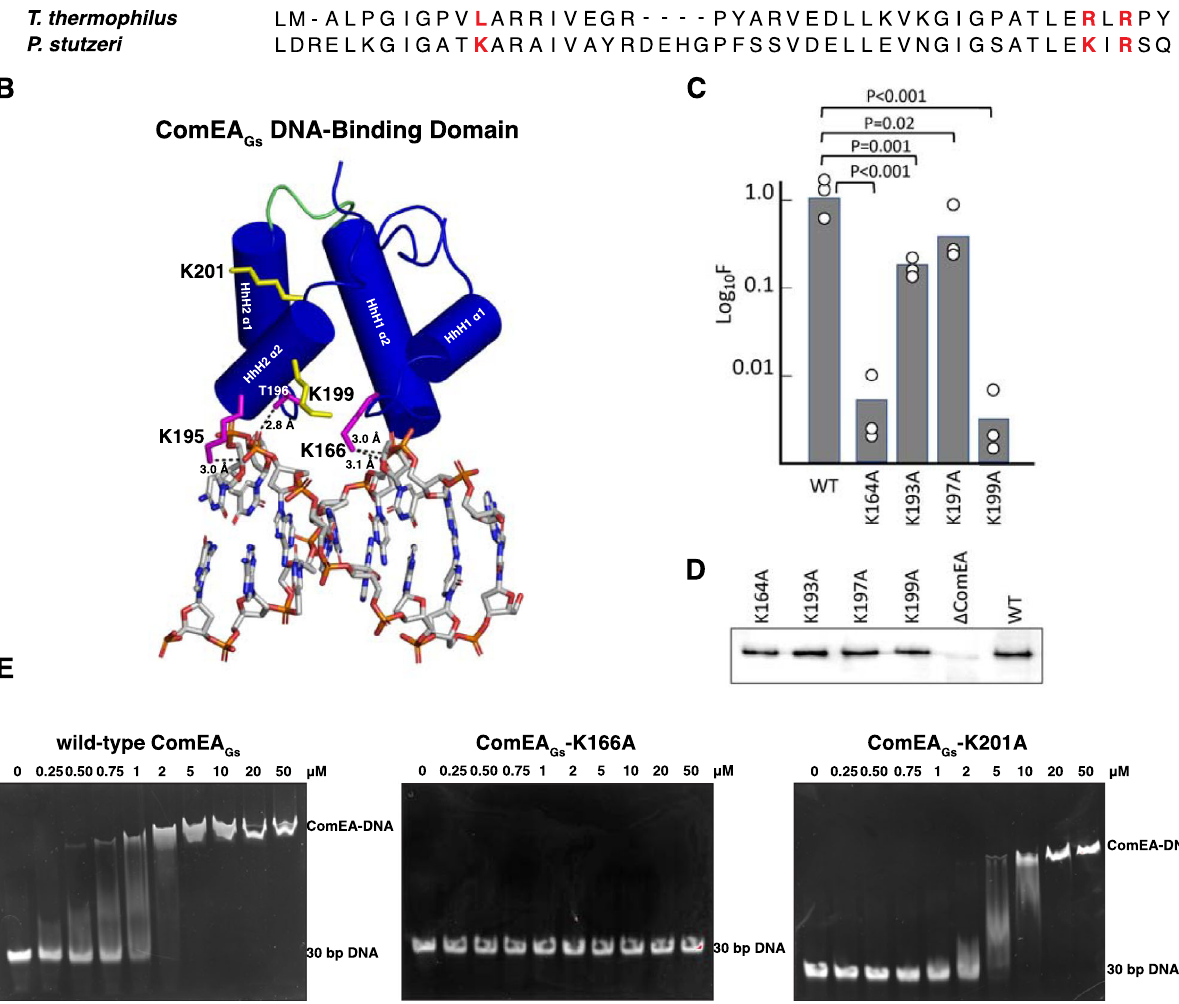
Fig. 7 | DNA binding to ComEA for transformation. A Alignments of the HhH motifs from ComEA proteins expressed by four Gram-positive (top) and Gram- negative (bottom) bacteria that have been used for transformation studies. The four lysine residues chosen for mutagenesis are highlighted in red. Secondary structure assignments were derived from the crystal structure of ComEA Gs . B Model of the ComEA Gs DNA-binding domain ( α -helices depicted as cylinders) in complexwithdsDNA(depictedassticks).TheloopconnectingtheHhH1andHhH2 is colored green. Hydrogen bonds are depicted as black dashed lines. For clarity, ComEA Gs is depicted in complex with 8bp central to the complex rather than the 15bpusedinre fi nement. C TransformationfrequenciesfortheHhHmotifmutants. Transformation experiments were performed as biological triplicates and average